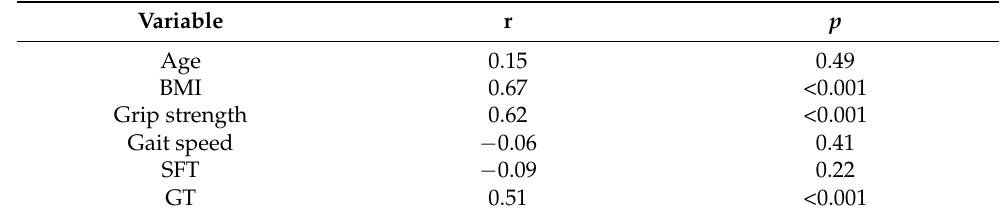
Table 2. Univariate analysis by Pearson correlation